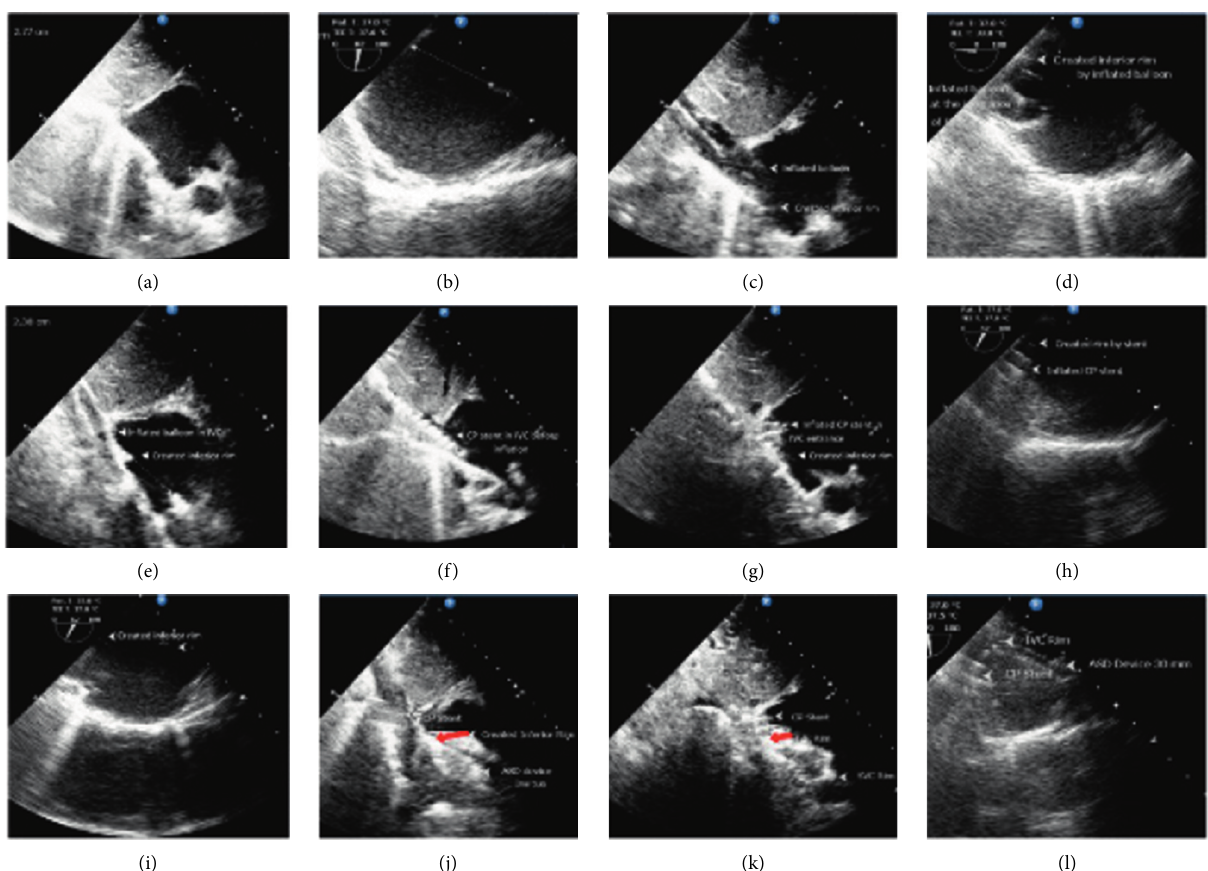
Figure 4: (a) Transthoracic echocardiorgraghy (TTE) imaging in subcostal view demonstrates a large secundum ASD with a totally absent inferior rim. (b) TEE imaging in long axis bicaval view demonstrates large secundum ASD. (c) TTE imaging in subcostal view demonstrates the inflated Z-med balloon with the created inferior rim (arrows). (d) TEE in modified oblique plane demonstrates the inflated balloon at the entrance of IVC with created inferior rim. (e) TTE imaging in the subcostal bicaval view demonstrates the inflated balloon with a created inferior rim. (f) TTE imaging in subcostal bicaval view shows the mounted uncovered CP stent at the entrance of the IVC before the inflation. (g) TTE imaging in subcostal bicaval view demonstrates the inflated uncovered CP stent at the entrance of the IVC with the created inferior rim. (h, i) TEE imaging in a modified long axis view (angle 67 ° ) demonstrates the created inferior rim (upper arrow) by tight inflation of an uncovered CP stent at the entrance of the IVC (lower arrow). (j, k) TTE imaging in subcostal long axis view demonstrates the atrial septal occluder in proper position capturing the created inferior rim (red arrow). (l) TEE imaging in long axis bicaval view demonstrates the proper position of the atrial septal occluder capturing the new inferior rim (upper arrow) which has been created by inflation of uncovered CP stent (lower arrow) at the entrance of